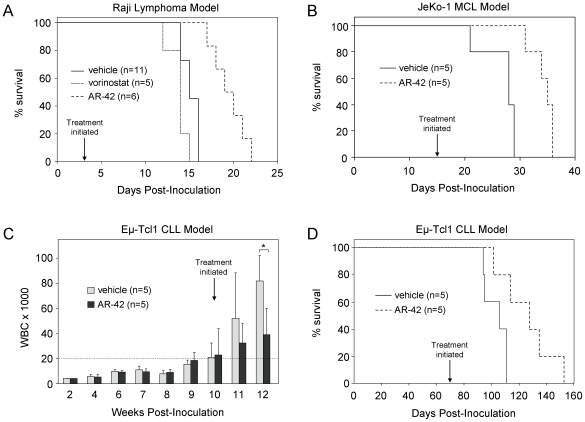
AR-42 shows in vivo efficacy in multiple models of B-cell malignancy.(A) SCID mice were engrafted with two million Raji cells via tail vein injection. Starting 3 days post-inoculation, mice were treated by oral gavage with vehicle only daily (n = 11), vorinostat at the maximum tolerated dose of 50 mg/kg daily (n = 5), and AR-42 at 75 mg/kg (n = 6) Monday, Wednesday and Friday. The median survival advantage in the AR-42 group relative to the vehicle control group was significant (p = 0.001). (B) SCID mice were engrafted with forty million JeKo-1 cells via tail vein injection. Starting on day 15 post-inoculation, mice were treated intraperitoneally with vehicle alone or 20 mg/kg AR-42 every three days (n = 5 per group). The improvement in median survival relative to control was significant (p = 0.003). (C) SCID mice were engrafted with one million Eμ-Tcl1 leukemia cells via tail vein injection. When the circulating leukocyte count averaged 20,000 cells/µL across the group (dashed horizontal line; 69 days post-inoculation), mice were randomized to two cohorts and treated Monday, Wednesday and Friday for two weeks with vehicle only (light bars) or with AR-42 at 75 mg/kg via oral gavage (dark bars) (n = 5, both groups). *The decrease in circulating leukocytes in AR-42 treated mice vs. controls at week 12 relative to week 10 was significant (p = 0.0007). (D) Animals in (C) were followed for survival (n = 5 per group). The increase in median survival in the AR-42 group relative to control was significant (p = 0.025).